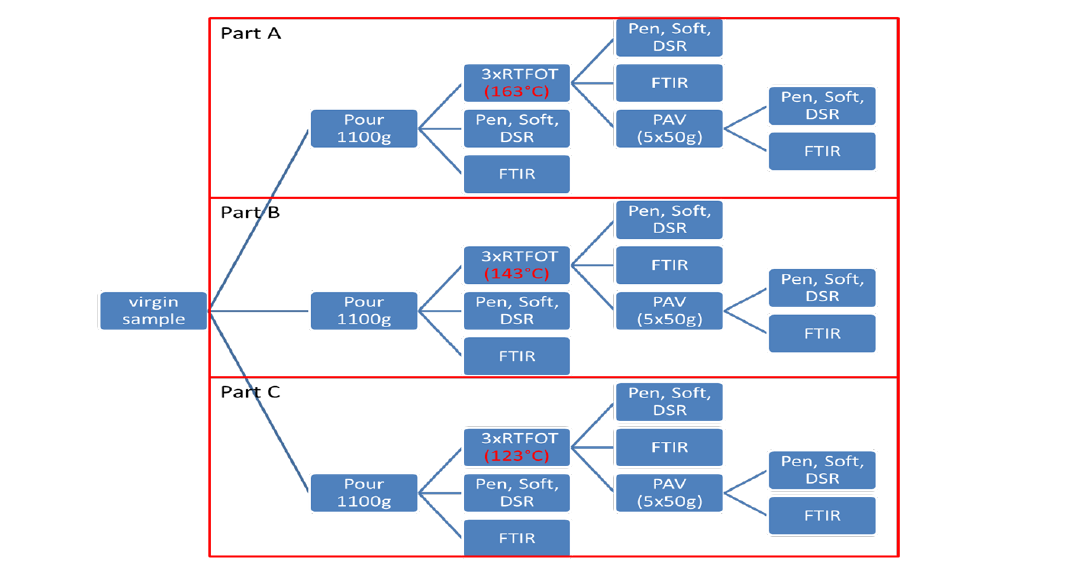
Figure 2. Experimental program of the round robin tests for binder evaluation.